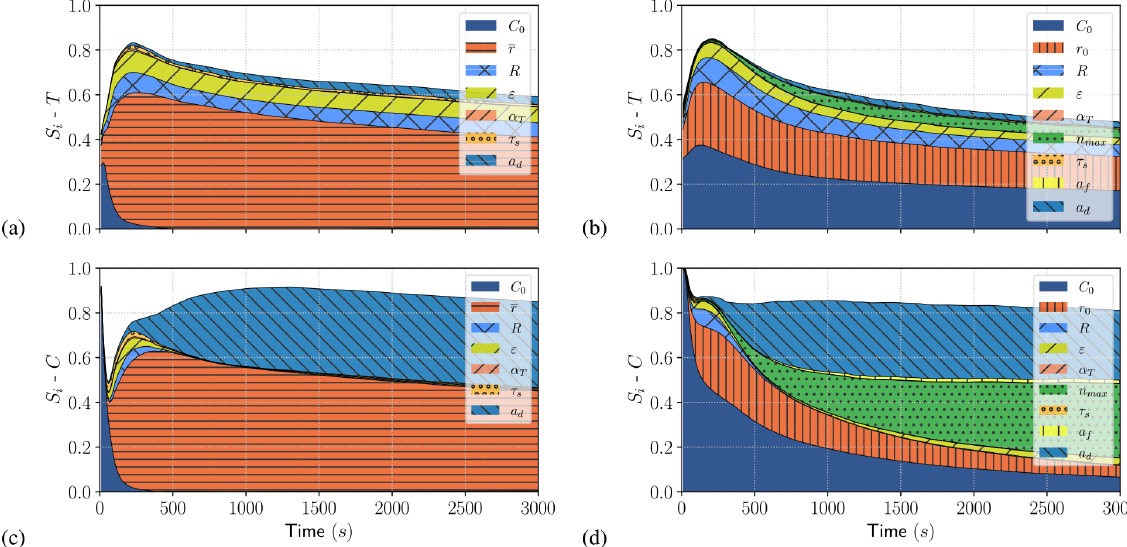
Figure 9. Time series of first-order Sobol indices ( S i ) for SSC (case 3) for temperature (a) and frazil (c) and MSC (case 4) for temperature (b) and frazil (d)